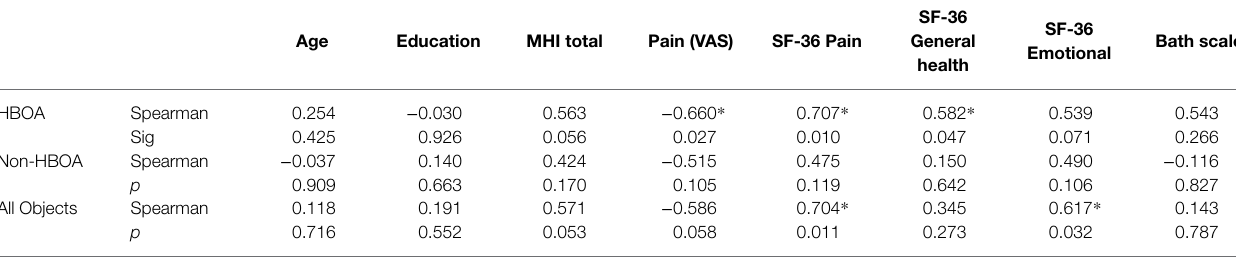
TABLE 3 | Spearman Correlations between The Object Assembly Tasks and The Demographic and Clinical Data.